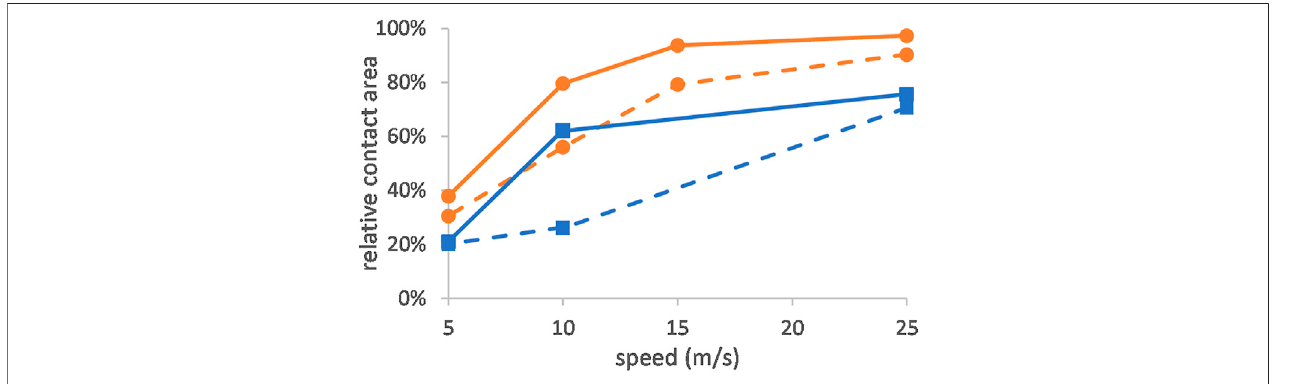
FIGURE6| RelativecontactareabehindtheXCski(orangecircles)andthe fl atski(bluesquares)afterrun1(dashedlines)andrun5(fulllines)atspeedsof5,10,15, and 25 m/s under the assumption that the contact spot temperature does not exceed 0 ° C.